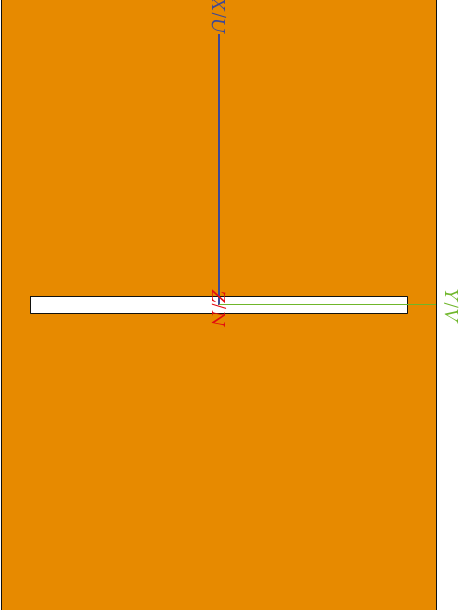
Figure 4: Defected ground plane (DGP) for the recon fi gurable dual-band antenna.